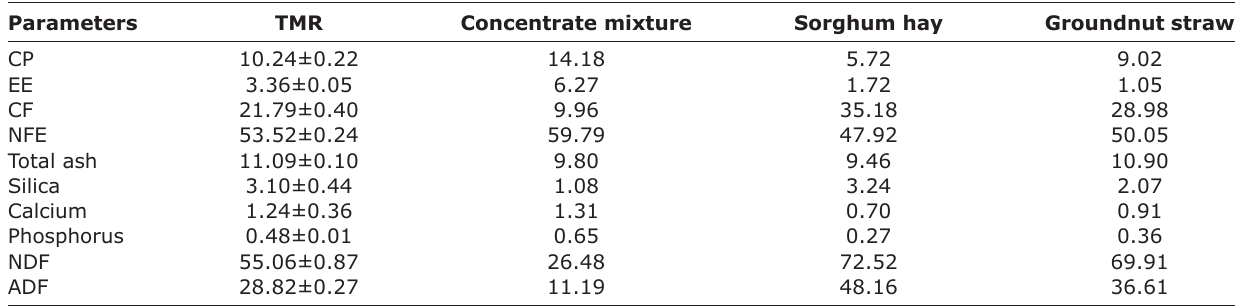
Table-1: Average proximate composition and fiber fractions (% on DM basis) of feeds and fodder.